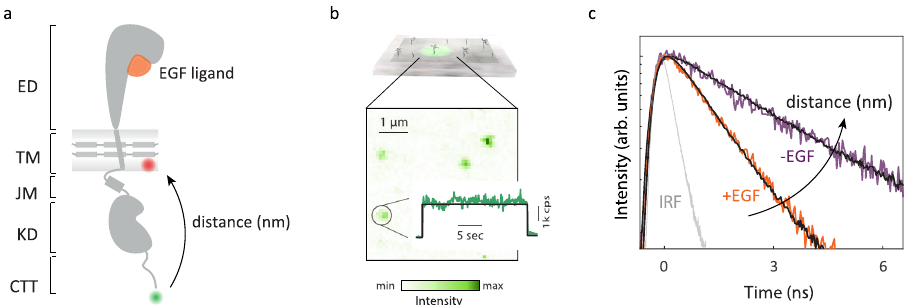
Fig. 1 smFRET measures intracellular conformational states of full-length EGFR in a nanodisc. a Full-length, monomeric EGFR (solid gray) embedded in a nanodisc. The nanodisc is a lipid bilayer (shaded gray) belted by an amphiphilic apolipoprotein (solid gray). EGFR consists of a 621-amino acid extracellular region (ED) that binds EGF (orange), a 24-amino acid transmembrane-spanning domain (TM), and an intracellular region, which is a 37-amino acid juxtamembrane domain (JM), a 273-amino acid kinase domain (KD) and a 231-amino acid disordered C-terminal tail (CTT) (Supplementary Fig. 1). Green and red spheres indicate the donor and acceptor dyes, respectively. b Top: Ni-NTA coated coverslip binds EGFR nanodiscs via a His-tag on the apolipoprotein. Bottom: fl uorescence intensity from a confocal image for a representative region ( λ exc = 550nm) where green spots are immobilized EGFR nanodiscs. Number of detected photons for each 100 ms interval generates a fl uorescence intensity trace (green) with the average intensity indicated (black). c Histogram of the arrival times of detected photons generates the donor lifetime decay pro fi le. Representative decay pro fi les of EGFR in the presence (orange) and absence (purple) of the EGF ligand in a neutral bilayer with fi t curves (black). The instrument response function (IRF) is shown in gray.